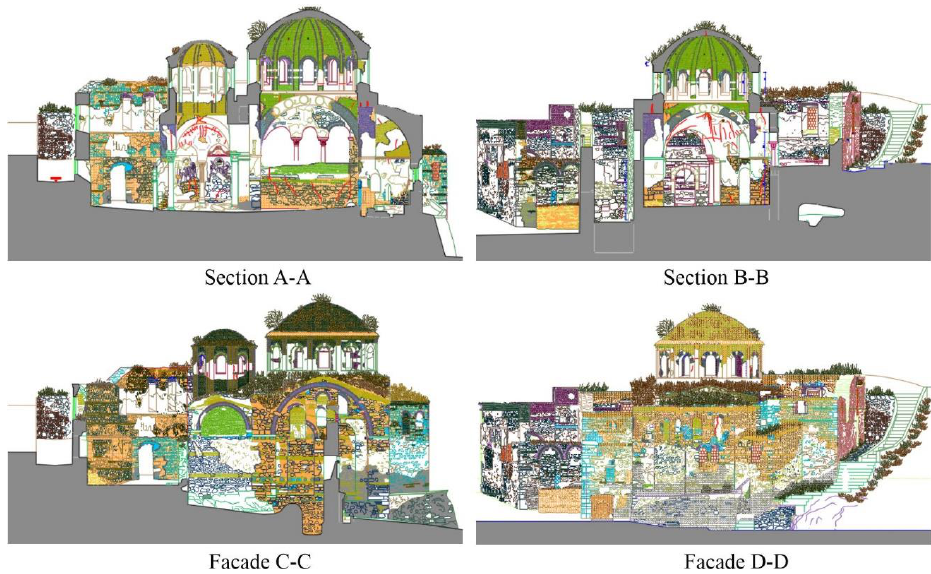
Figure 3. Section and facade views of the structure [41].